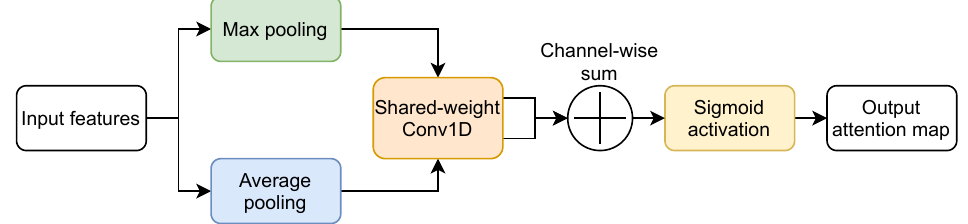
Figure 14. Structure of the MECA module proposed by Guo et al.